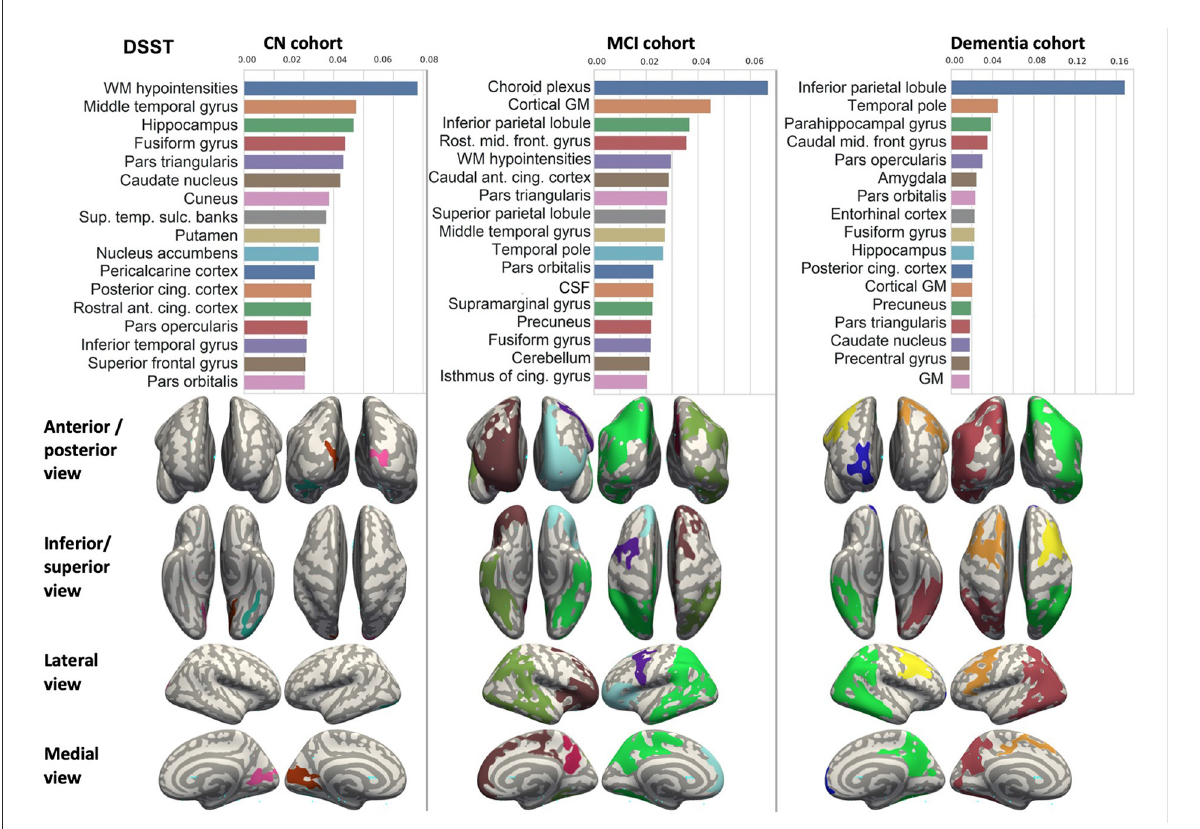
FIGURE6 Brain structures ranked according to information gain value for DSST score prediction. Inflated cortical representations showing significant correlations between cortical volumes and test